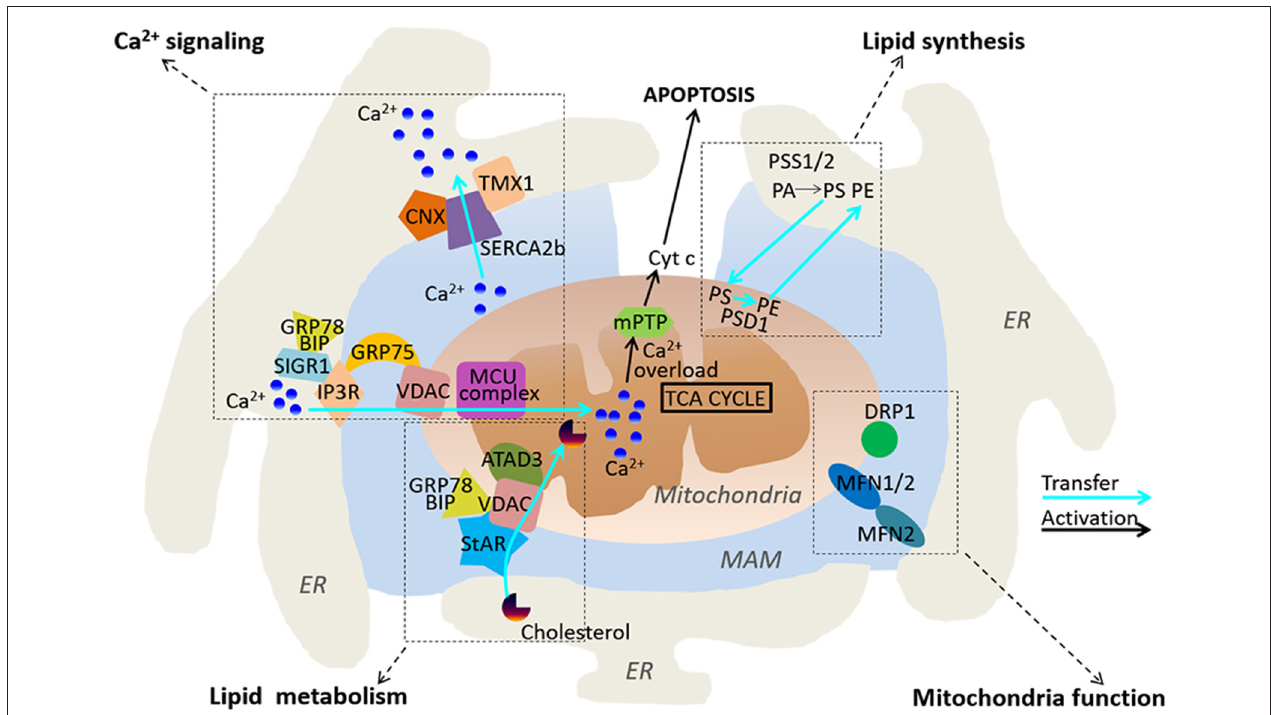
FIGURE 1 | Functional roles of MAMs. MAMs play regulatory roles in Ca 2 + signaling, lipid synthesis and metabolism, and mitochondria functions.